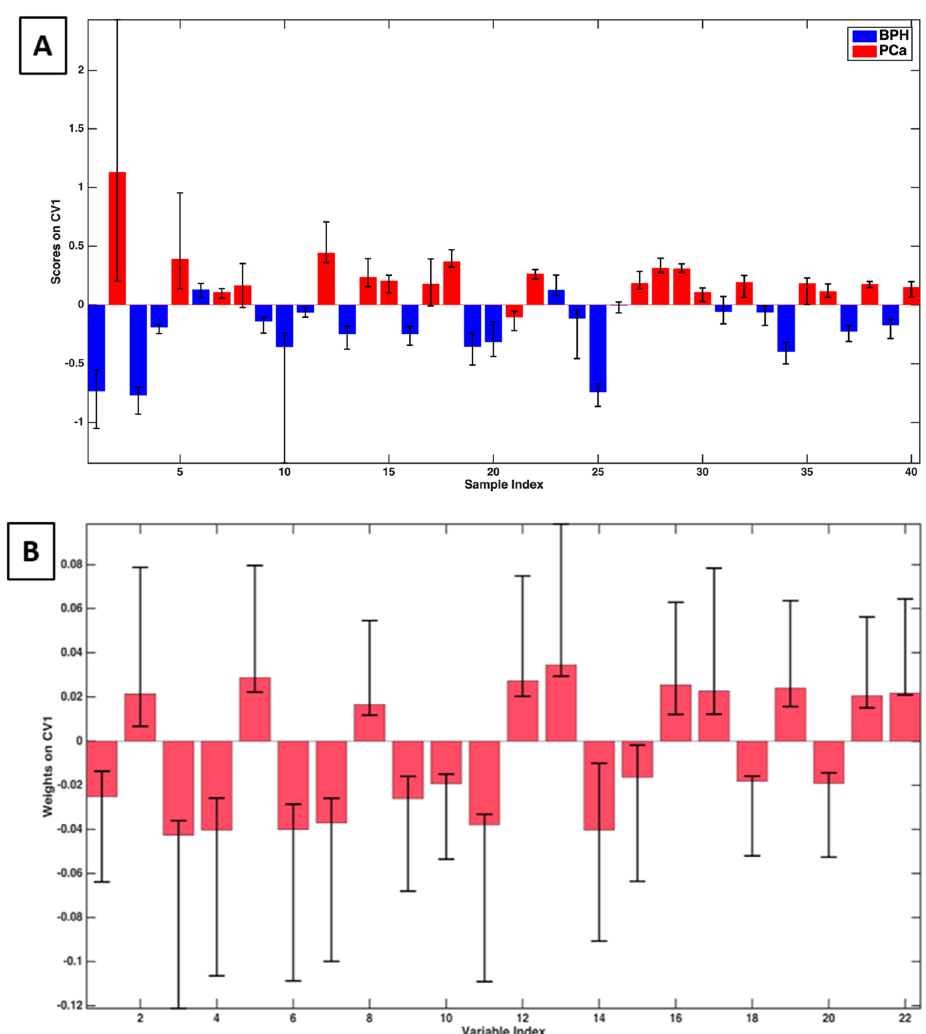
Figure 2. Graphical representation of the PLS-DA r-dCV model obtained for the ESI + dataset. ( A ) Scores of the samples along the first canonical variable. ( B ) Weights of the variables along the first canonical